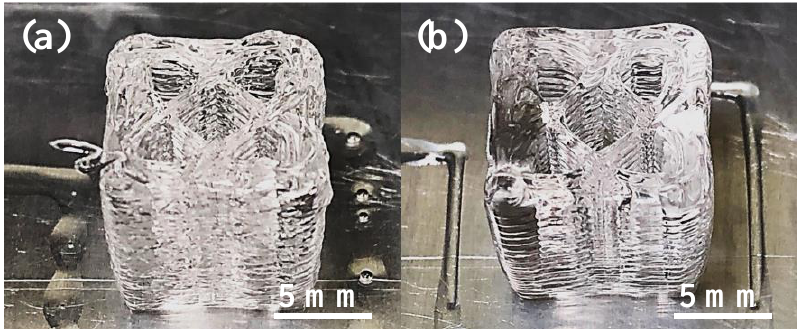
Figure 3. The 3D cubic-like constructs were printed through the self-fabricated 3D bioprinting system: ( a ) 3BE-2 combined with Ф 0.13 mm needle head and ( b ) 3BE-3 combined with Ф 0.13 mm needle head. The shape of the printed structure can be maintained for over 24 h using the combinations of 3BE-3.